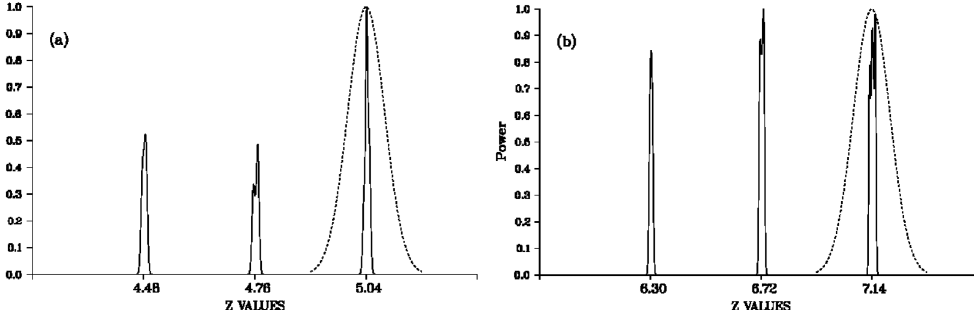
FIG. 11. Third harmonic pulse shape at different positions inside the undulator: (a) around the knee, 1 : 0 ¼ 7 : 71 (cid:2) 10 (cid:1) 4 MW ; (b) around the saturation, 1 : 0 ¼ 3 : 21 (cid:2) 10 (cid:1) 1 MW